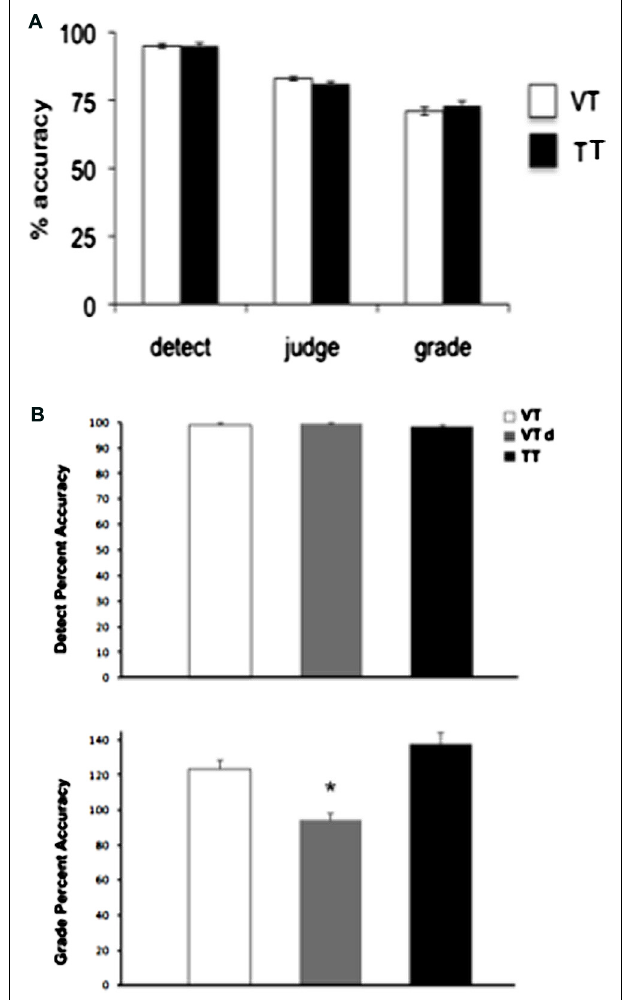
FIGURE 5 | Group means ( n = 10) for behavioural performance in Experiments 1 (A) and 2 (B). Performance is shown for the crossmodal visual + tactile task condition where the stimuli were presented simultaneously (VT, white bars) or with a 100 ms delay (VTd, gray bars). Black bars represent group data for the unimodal tactile condition (TT). Error bars show SEM, * denotes significance p < 0.05.